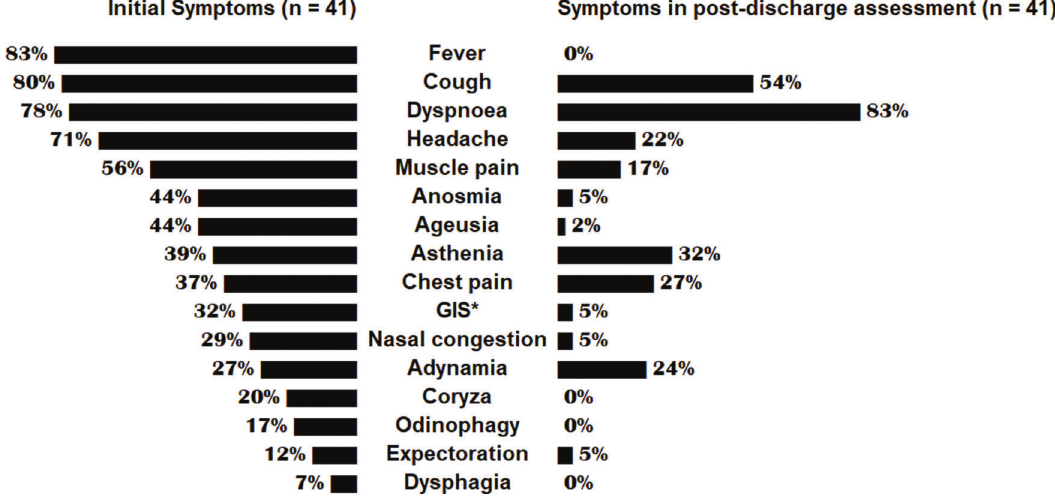
Figure 1 - Comparison between initial symptoms and symptoms in post-discharge assessment. *GIS: Gastrointestinal